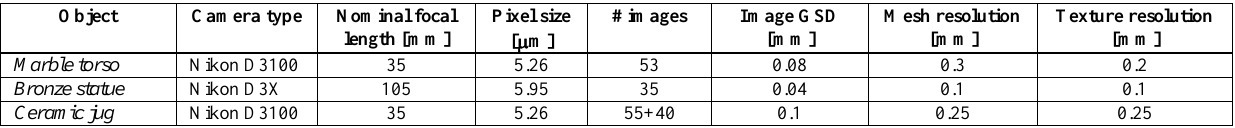
Table 1: Summary of the main parameters of the case